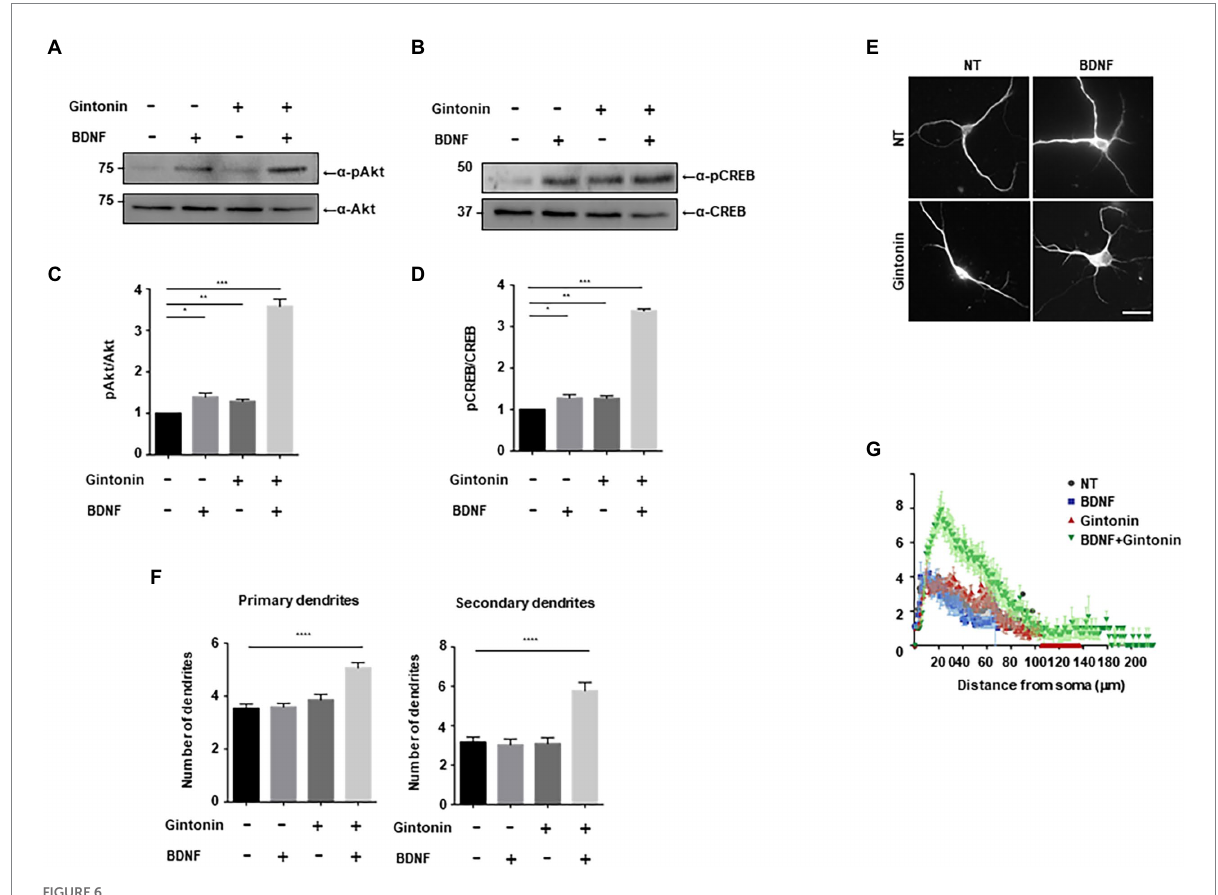
FIGURE 6 Gintonin and BDNF have a synergistic effect on dendritic growth. (A,B) Representative blots showing the effect of gintonin and BDNF co- treatment on Akt and CREB phosphorylation. DIV7 striatal neurons were treated with a suboptimal dose of gintonin (0.3 μ g/ml) in the presence or absence of BDNF (5 ng/ml). Lysates were used for the immunoblot analysis of phospho-Akt, Akt, phospho-CREB, and CREB. (C,D) Densitometric quantification of the results are shown in (A,B) . Results are means ± SEM from three independent experiments. (*p < 0.05, ** p < 0.01, *** p < 0.0005, Student’s t -test). (E) Representative images of gintonin and BDNF-treated striatal neurons. Cultured striatal neurons were treated with gintonin in the presence and absence of BDNF at DIV2. After 5 days of exposure, the cultures were fixed and stained with anti-MAP2 antibody. Neuronal processes were counted with fluorescent microscopy. Scale bar, 2 μ m. (F) Quantitation of the number of primary and secondary dendrites is shown in (E) . Results are presented as means ± SEM from three independent experiments determined from the analysis of 40 neurons per condition per experiment (**** p < 0.0001, Student’s t -test). (G) Sholl analysis of the dendritic arbor showing the synergistic effect of gintonin and BDNF co-treatment on striatal